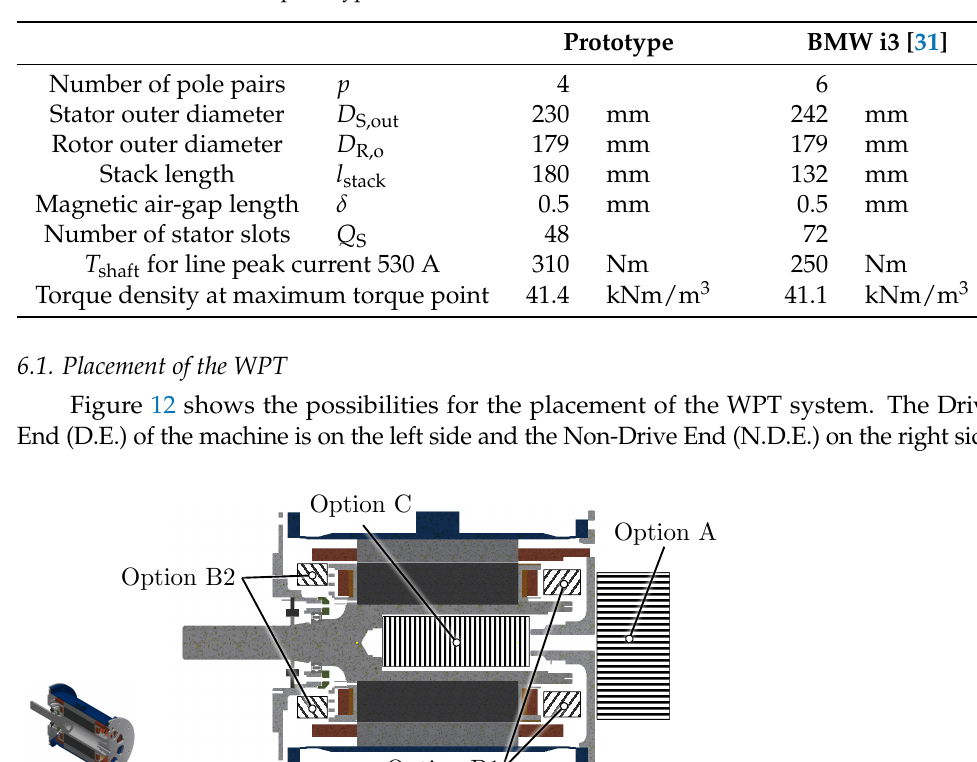
Table 2. Parameters of the prototype and the BMW i3.